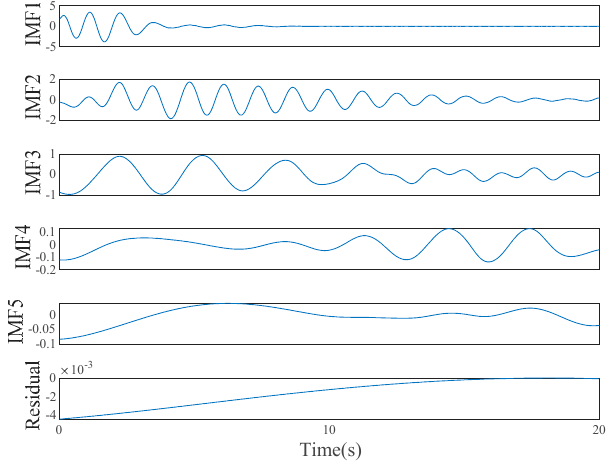
Figure 5. Effective IMFs and a residual signal after denoising. After denoising, the new signal c EMD ( t ) is reconstructed by IMFs and r . The comparison of the synthesized signal by EMD c EMD ( t ) with the original signal with noise (i.e., signal A) is displayed in Figure 6.